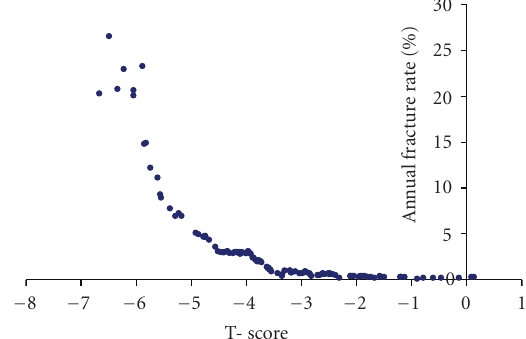
Figure 3: The annual hip fracture rate at di ff erent T-scores. Every dot represents one fracture. The annual fracture rate is estimated with greater uncertainty for T-scores below − 4 . 5 due to a limited number of